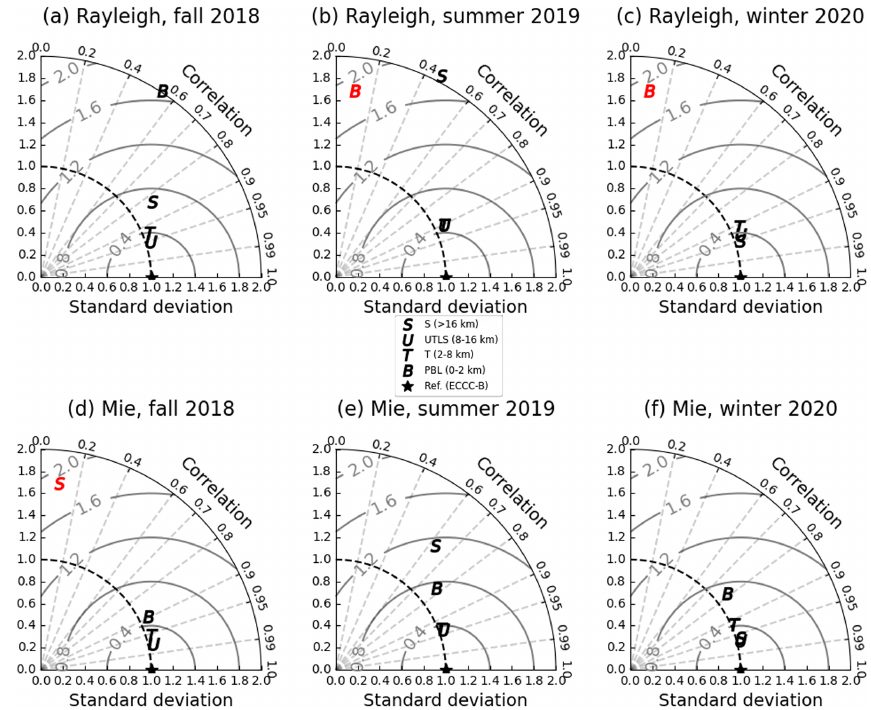
Figure 10. Normalized Taylor diagrams with ECCC-B as references for Aeolus measurements over the Arctic. The correlation coefficients and standard deviations are calculated for each layer. The angle indicates the correlation between Aeolus measurements and the reference. The distance to the origin represents the normalized standard deviation, and the distance to the star (reference) represents the normalized root-mean-square error. Rows are distinguished by channels; columns are distinguished by seasons. The red markers on the top left of the panels represent layers with normalized standard deviations that are outside the range shown ( > 2 . 2).